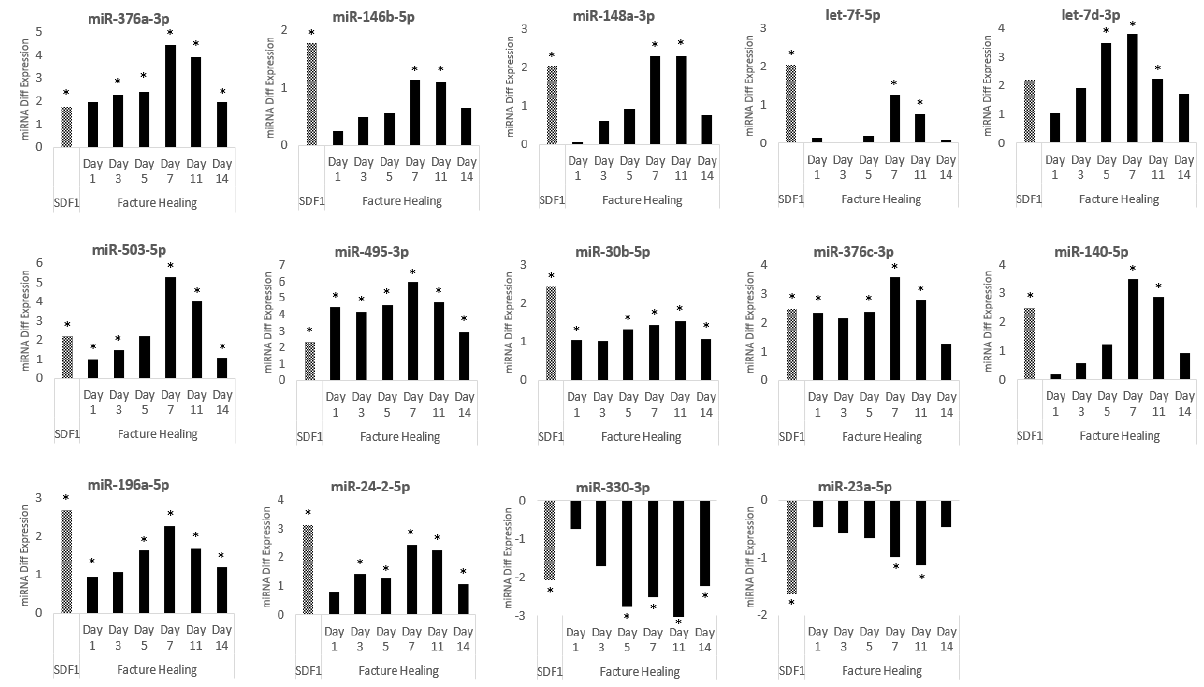
Figure 3: Common miRNAs regulated in presence of SDF-1 treatment (at 72 hours) and during murine femur fracture healing (across multiple time points ranging from day 1 through day 14). Fracture healing data was retrieved from GEO dataset uploaded by Hadjiargyrou et al. (GEO accession GSE76197) in which murine bone fractures were generated and miRNA-enriched RNA was isolated from calluses at post-fracture days 1, 3, 5, 7, 11, and 14 and compared to intact bone (control) ( n = 3). Microarray analysis revealed 306 and 374 up- and down-regulated miRNAs, respectively, of which 14 were similar to our study and presented in this figure with their respective fold changes. Significance in fold change (*) of GEO data was determined by GEO2R adjusted p -value <